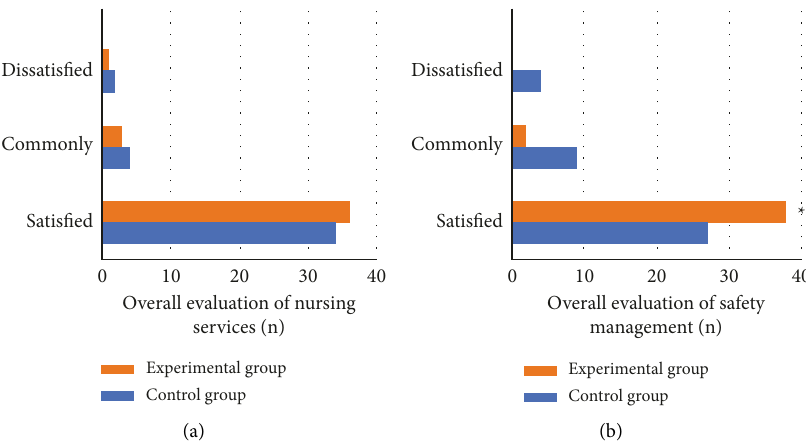
Figure 4: Results of overall patient satisfaction ( Note. ∗ represents a considerable difference vs. control group, P < 0 . 05).